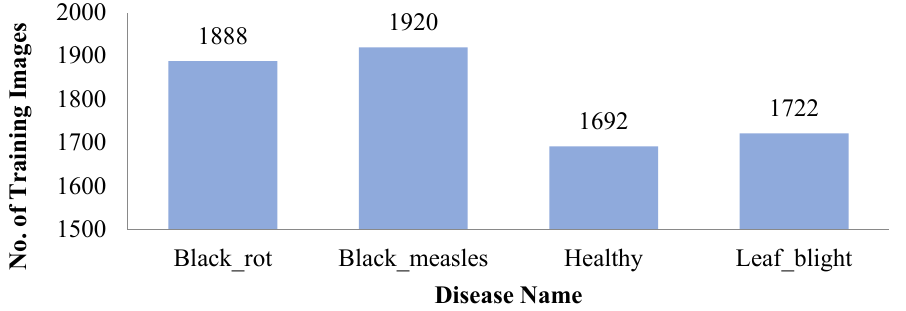
Figure 1. Number of Training Dataset.